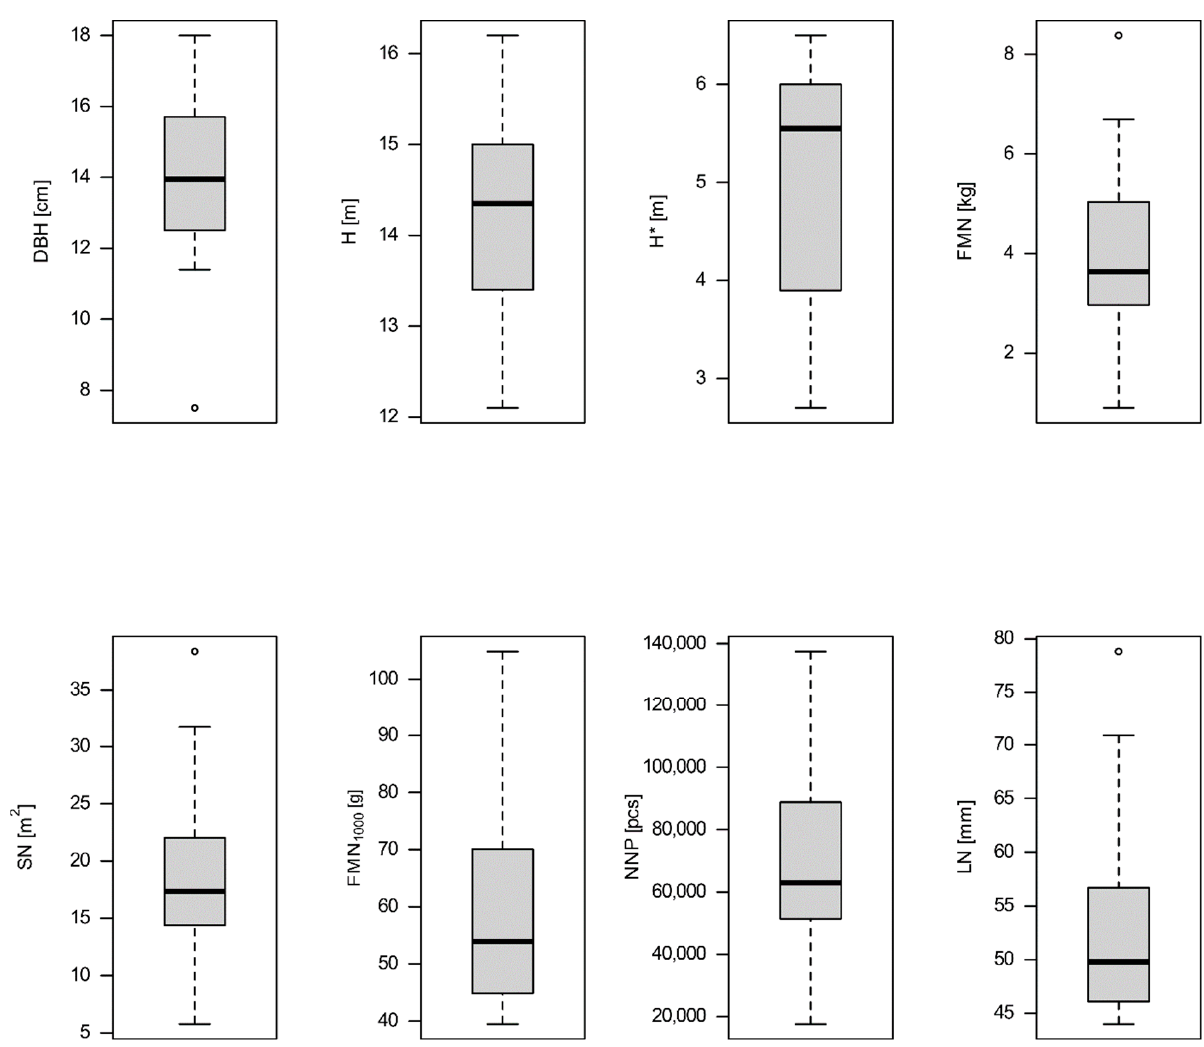
Figure 1. Median (horizontal line in box), the 25th percentile to the 75th percentile (box spans) and a ‘whisker’ ranging to maximum and minimum but no more than 1.5 times of the interquartile range (IQR) from the box top and bottom, respectively, (DBH—diameter breast height; H—tree height; H*—crown length; FMN—fresh mass of needles (Dry mass of needles = FMN·0.468); SN—surface of the needles; FMN 1000 —fresh mass 1000 pairs of needles; NNP—number of needle pairs in a sample tree; LN—mean length of needles).